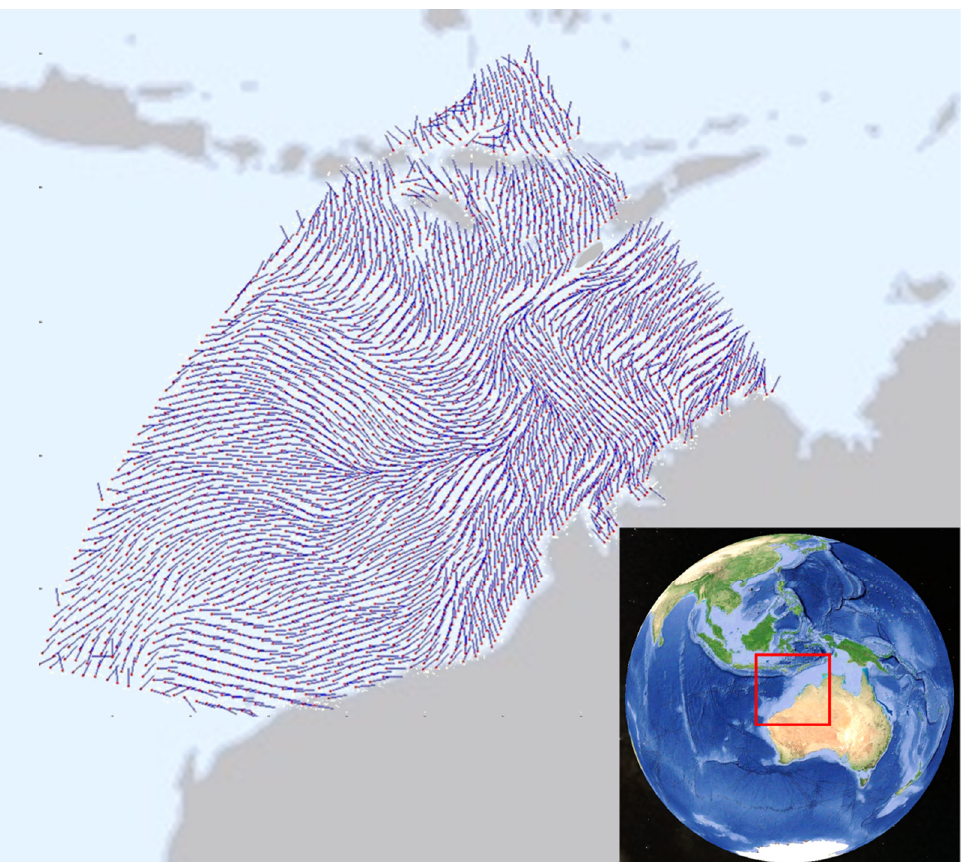
Figure 19. A map of wind direction covering over 2 million square kilometres, plotted at a degraded measurement resolution of ~25 km.